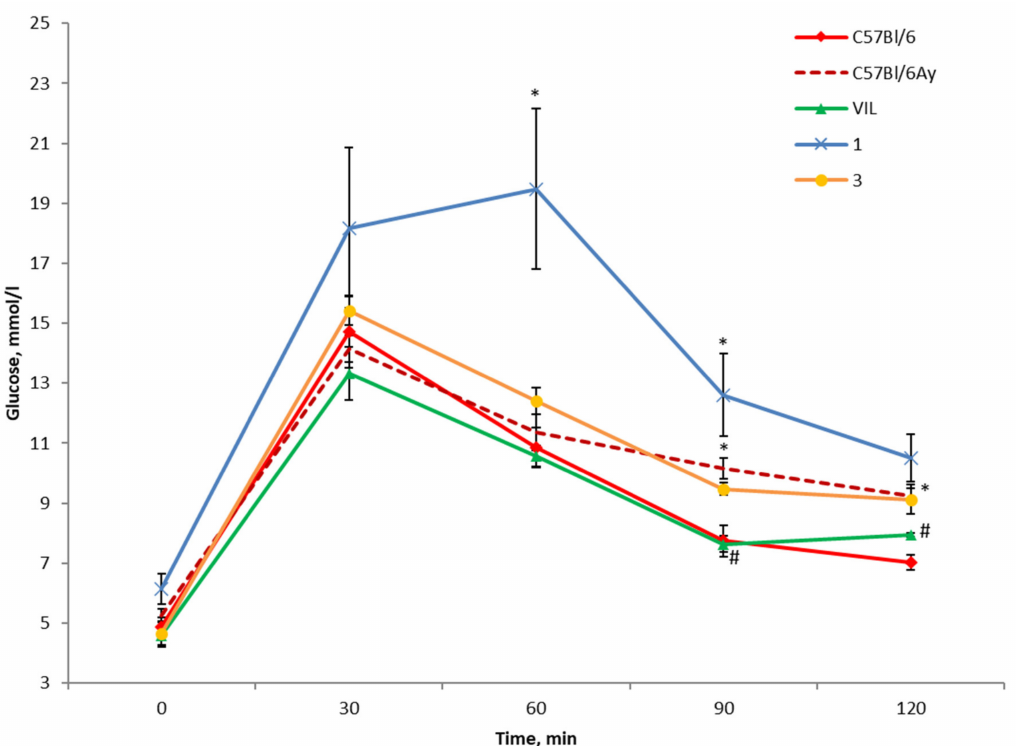
Figure 3. OGTT results in C57BL / 6 Ay (AY) mice after the first administration of compound 1 or 3 . * p < 0.05 as compared with untreated C57BL / 6 mice, # p < 0.05 as compared with untreated AY mice.